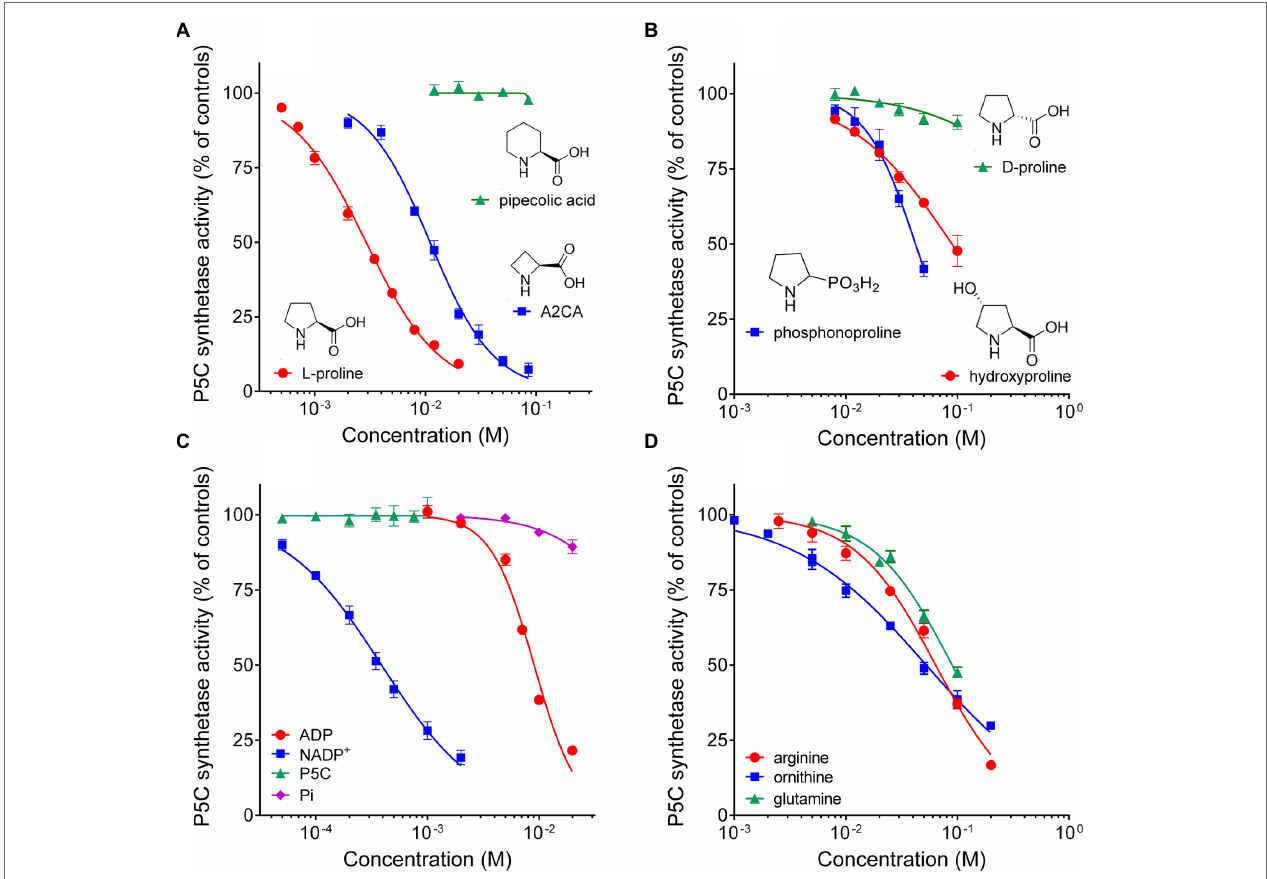
FIGURE 4 | Effect of reaction products and related amino acids on the activity of rice P5C synthetase 2. The activity of the purified protein was assayed in the presence of increasing concentrations of the final product of the pathway, L-proline, and its 4C (A2CA) and 6C (pipecolic acid) analogues (A) ; of the D-isomer and other natural and synthetic analogues of proline (B) ; of the four enzyme products (C) ; of some amino acids that are metabolically interconnected with proline, or represent a cellular index of nitrogen availability (D) . Results were expressed as per cent of mean values in untreated controls. Presented data are means ± SE over three technical replicates. Each experiment was repeated three times with different enzyme preparations, and virtually identical patterns were obtained. Ornithine and arginine were added as hydrochlorides. To rule out the possibility that effects may depend on a consequent change in pH and not to the added substances, the actual pH in each sample was measured with a microelectrode at the end of the incubation. Non-linear regression of data (log[inhibitor] vs. normalized response – variable slope) was performed using GraphPad Prism; IC 50 values and their confidence intervals are reported in Table 2 .